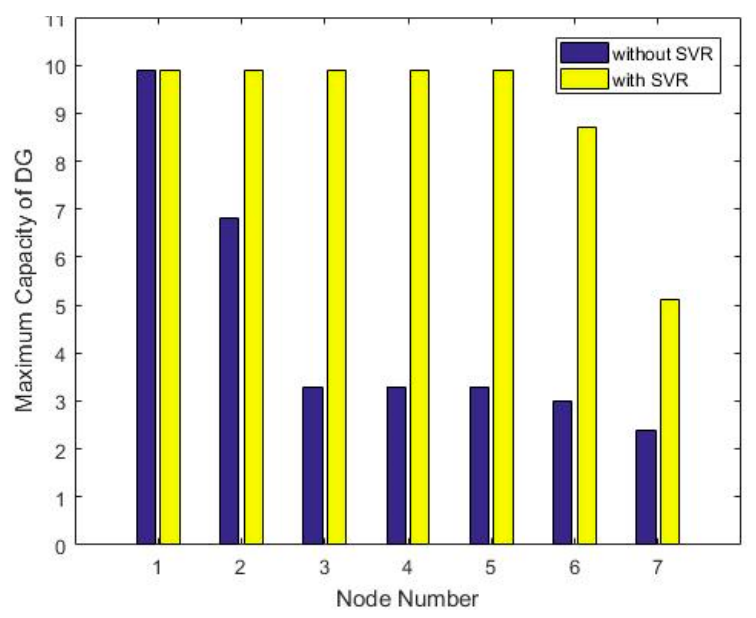
Figure 3. Maximum capacity DG penetration with and without SVR.